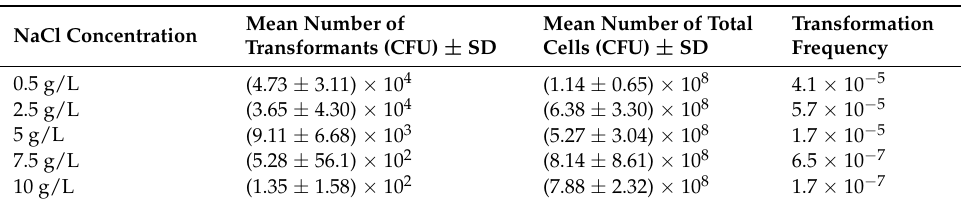
Table 2. Effects of sodium chloride on the transformation frequency of Acinetobacter baumannii A118 in semi-solid medium.